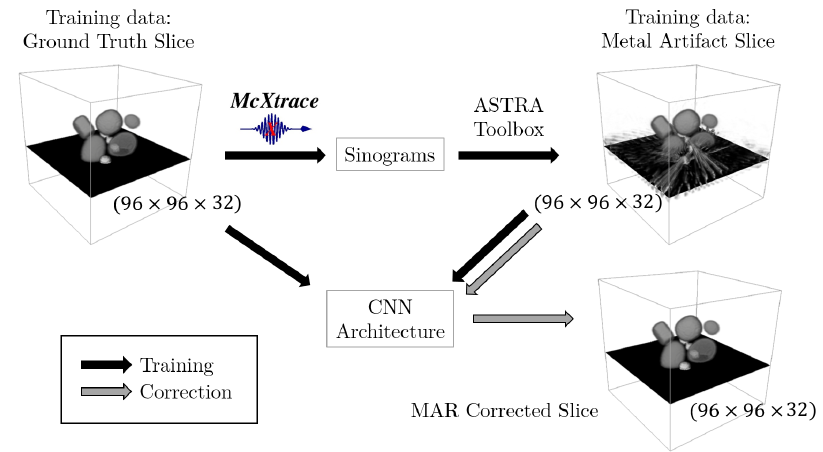
Figure 1. A sketch of the MAR correction using spectral CNN. The 3D volume of the ground truth phantom of the materials is given as input to the McXtrace software package to obtain physically modeled spectral sinograms via X-ray tracing simulations. These are reconstructed into metal artifact affected volume reconstruction, using the ASTRA [29] toolbox. For each vertical slice of the object’s 3D volume, a pair of ground truth and reconstructed spectral volumes (where the third dimension is now the energy channel) is given as input training data in the CNN architecture (black arrow). Once trained, the CNN architecture corrects directly the metal-artifact affected spectral slices (gray arrow). The metal objects are visible as the lighter gray